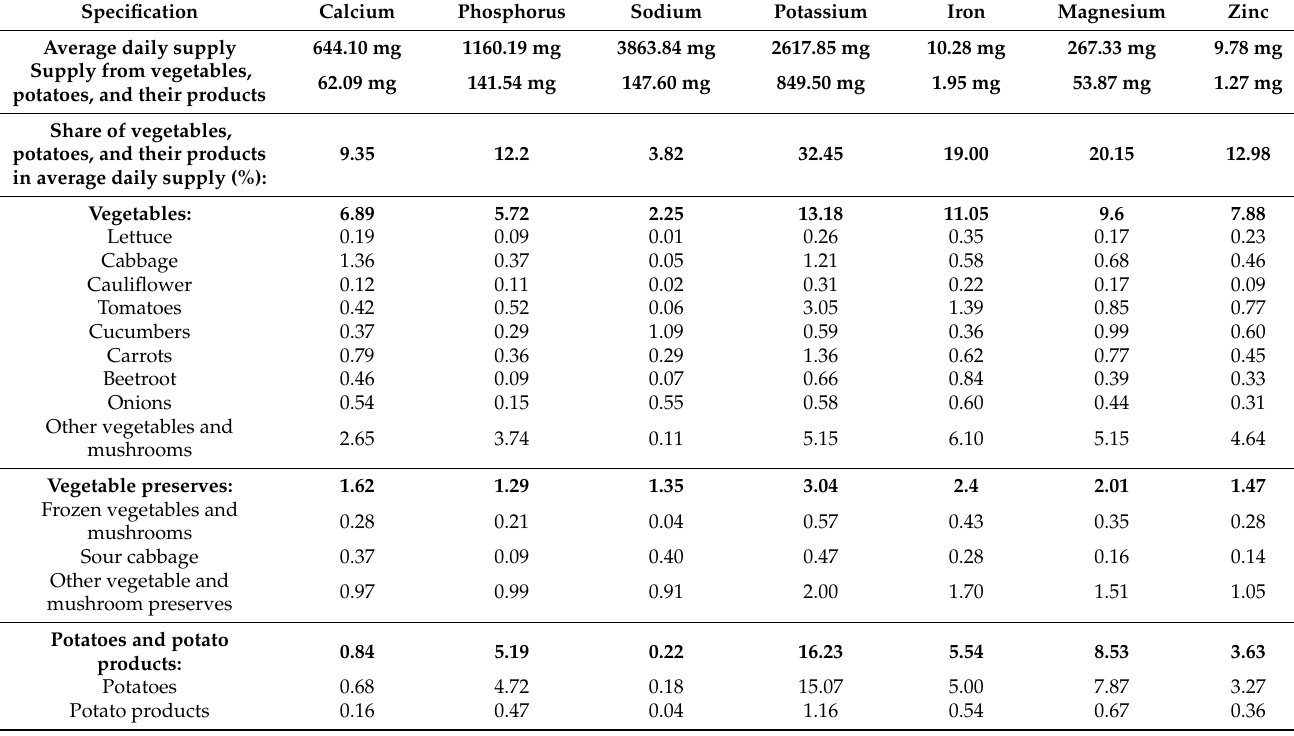
Table 3. Vegetables, potatoes, and their products as sources of minerals in the